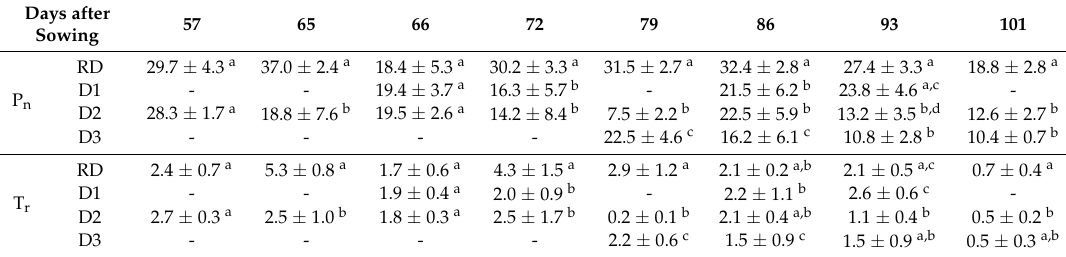
Table 2. Responses of P n and T r to drought